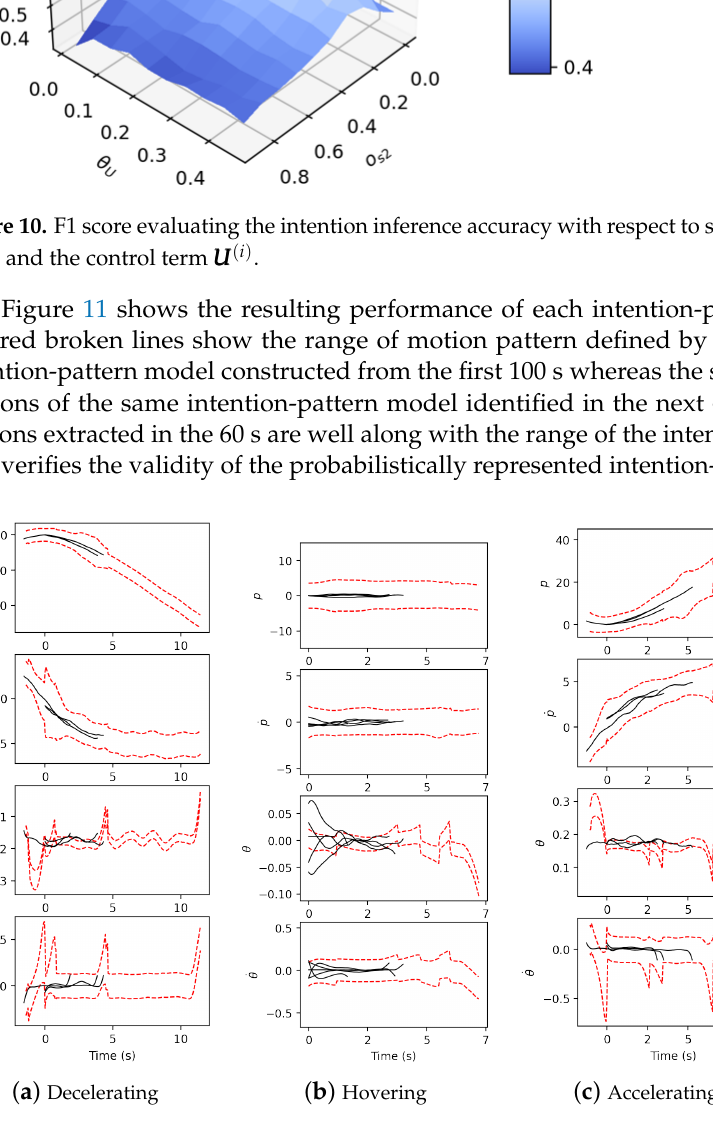
Figure 11. Validation of the constructed intention-pattern